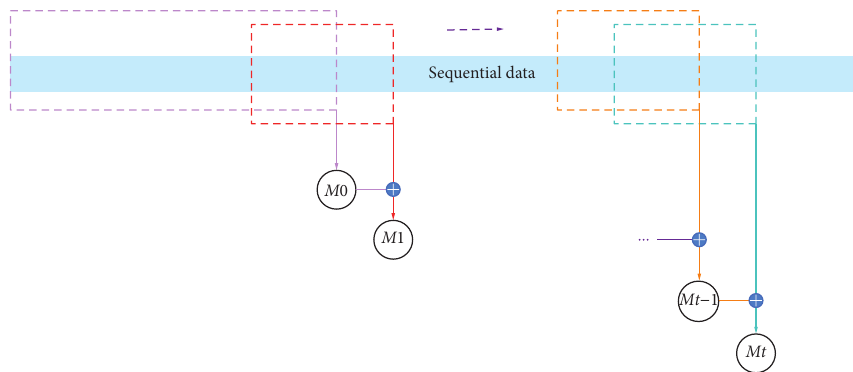
Figure 3: Work-flow of the online prediction framework for COVID-19 infection trend. Table 1: Number of users enrolled in the study.